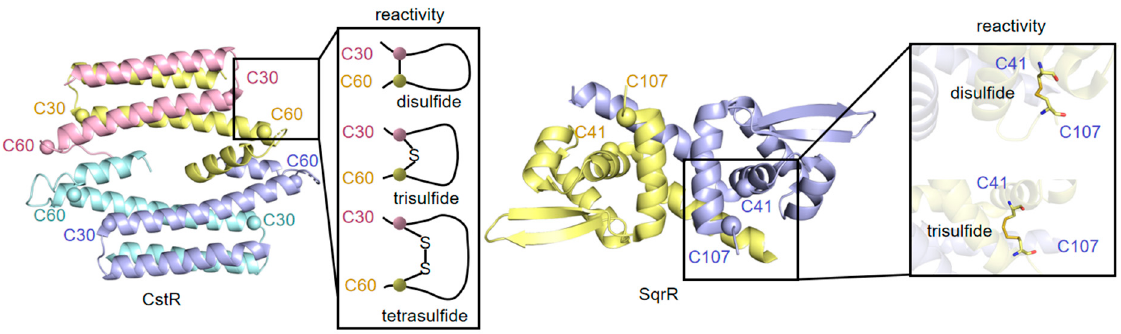
Figure 6. Structures and responding mechanism of CstR to RSS. Left, CstR (PDB ID: 7MQ2), which exists as homotetramer. Right, SqrR (PDB: 6O8N), which exists as homodimer. Expanded regions show the mechanism of activation. Both regulators use multiple cys thiols for sensing RSS by forming di-, tri-, and tetra-sulfide bonds.